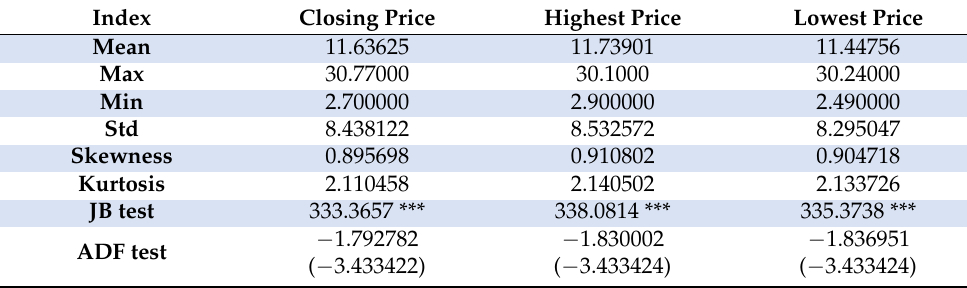
Table 1. Statistical description of sample